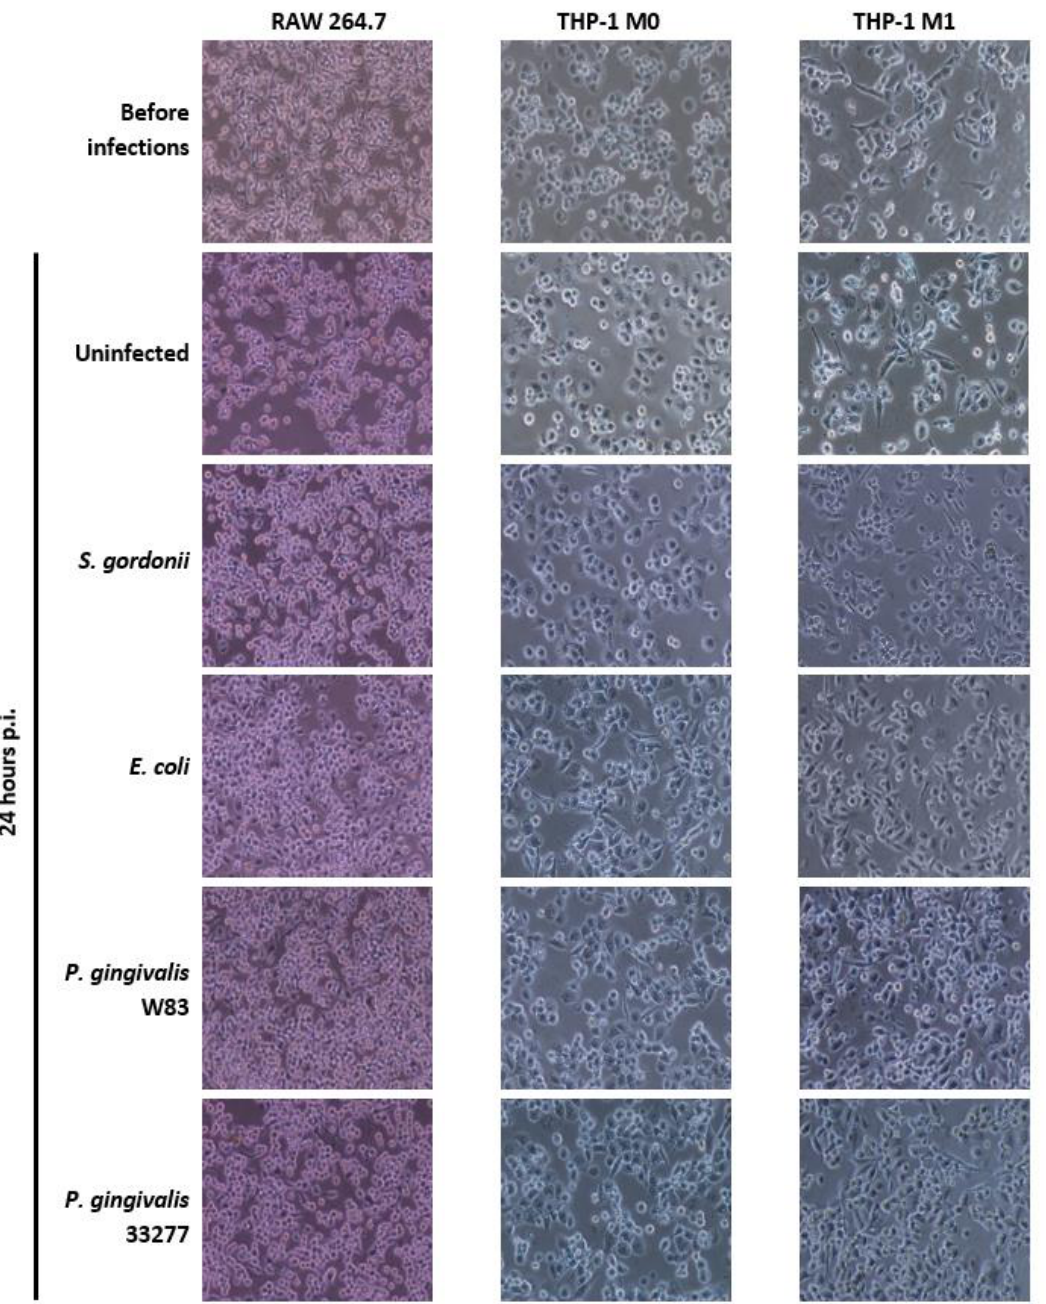
Figure 3. Cellular Morphology: Cellular images of RAW 264.7, THP-1-derived M0, and M1 cells were taken before bacterial infections and 24 h p.i. Representative images of three independent experiments at 100 ×